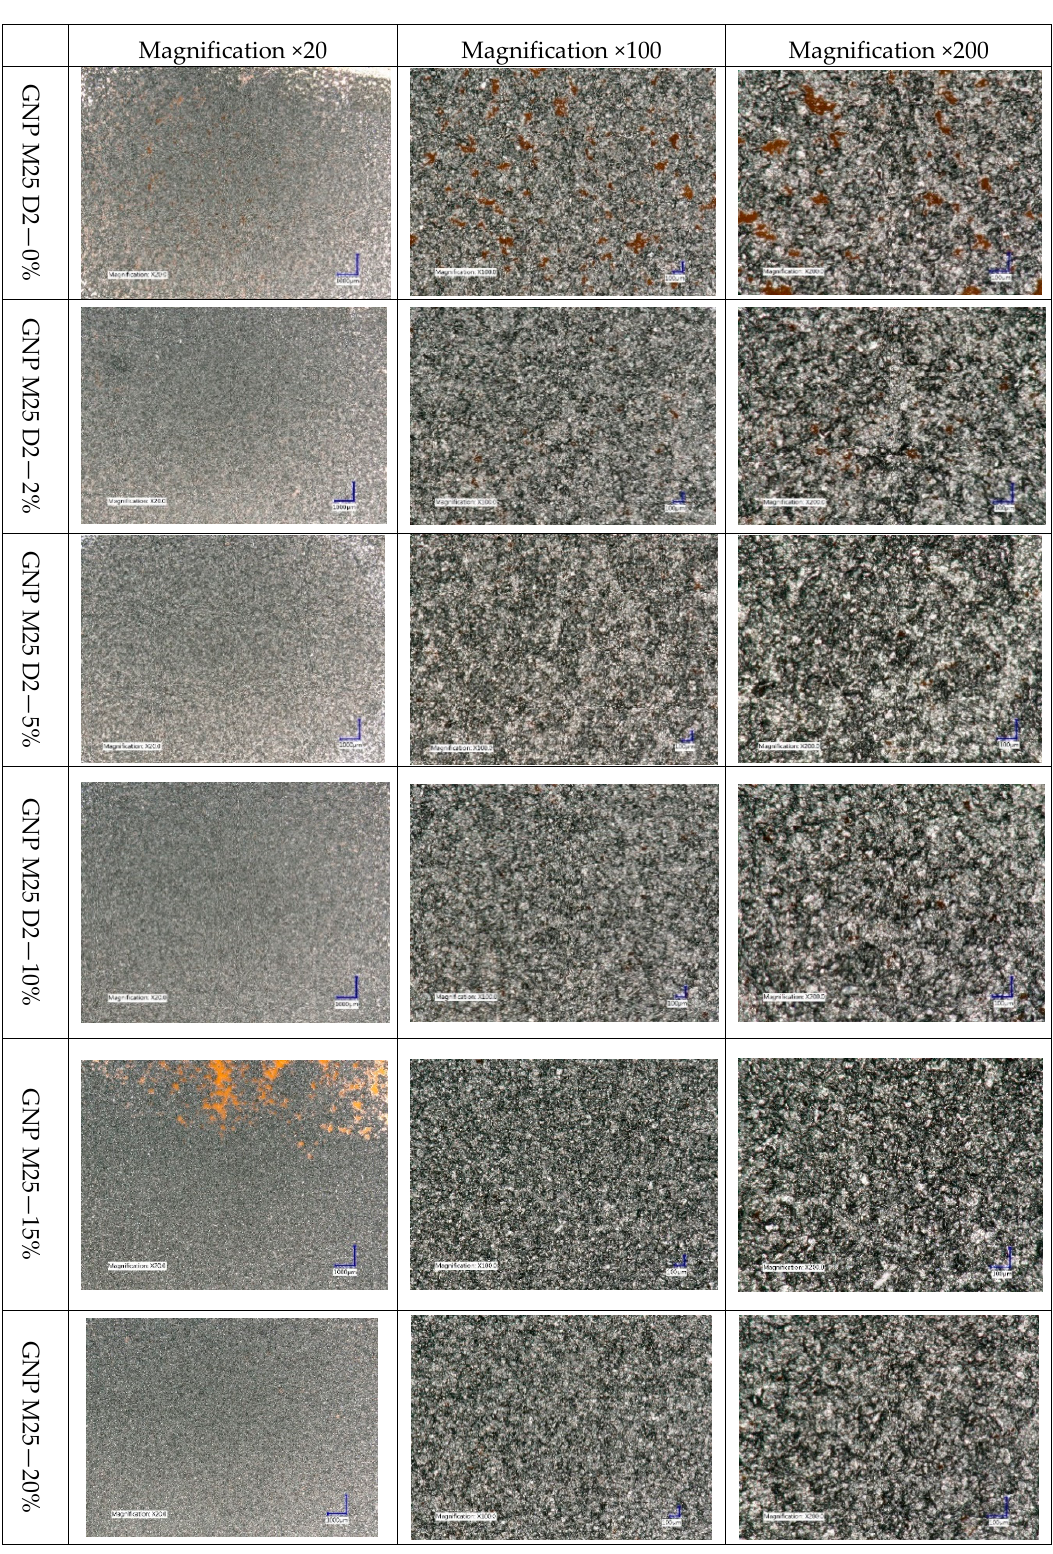
Figure 4. Digital microscope photographs showing the quality of coatings made of the inks with various surfactant content.